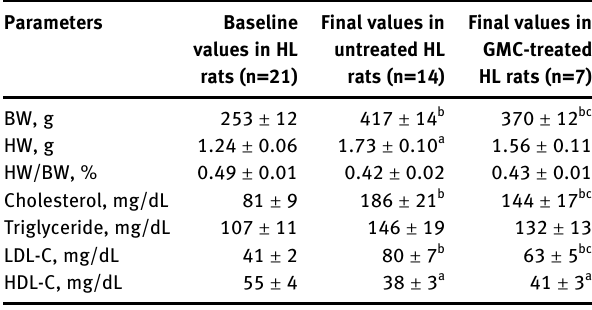
Table  : Generalinformationofhyperlipidemicratsbeforeandafter feeding high-fat